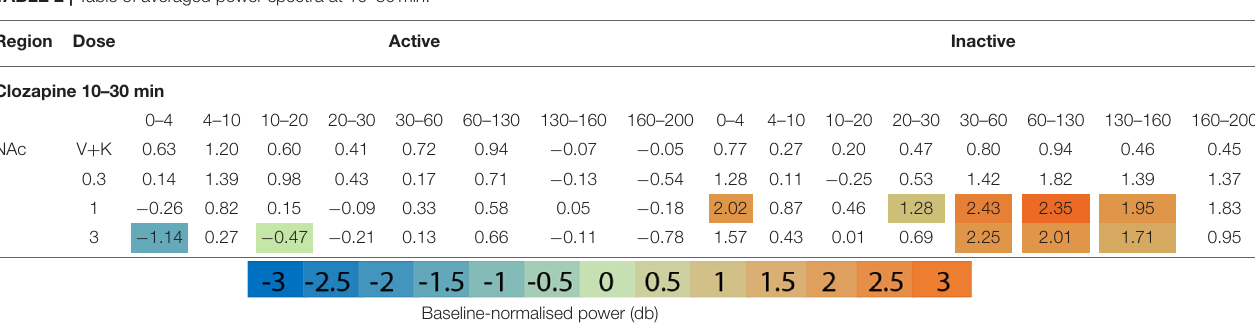
Baseline-normalised power